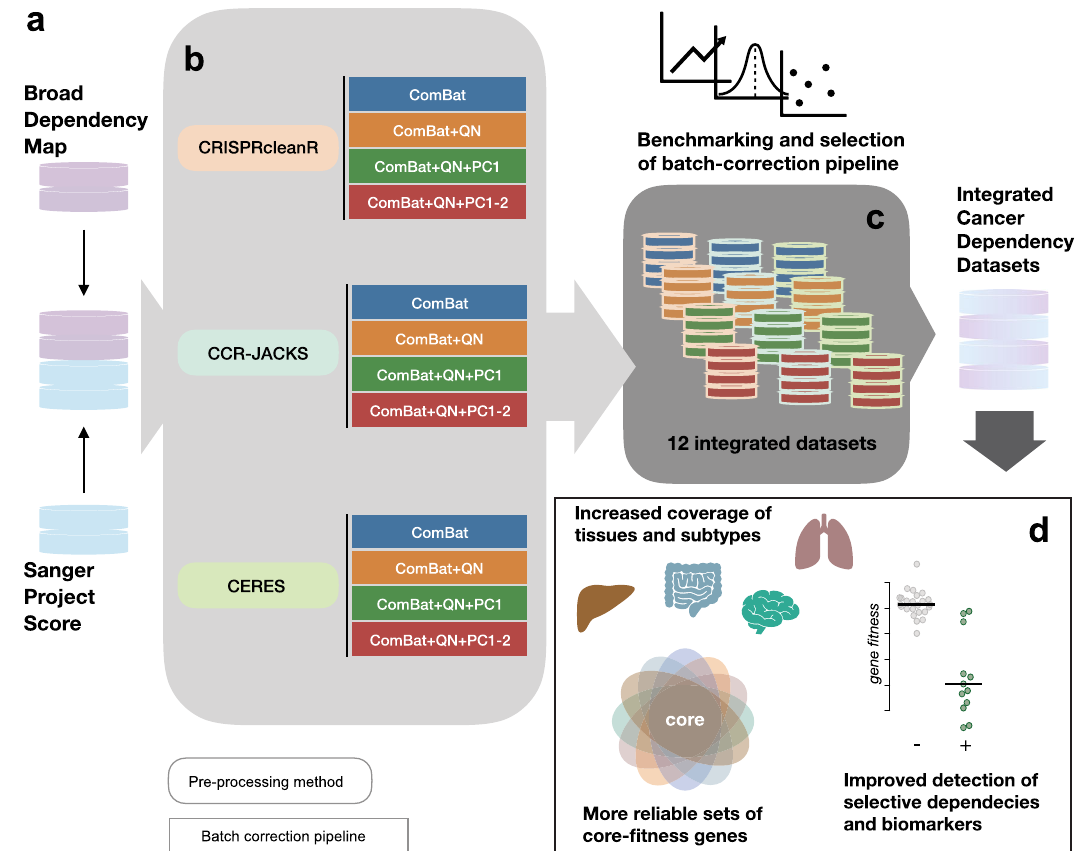
Fig. 1 Schematic of the integration strategy. a Broad and Sanger gene-dependency datasets (raw count data of single-guide RNAs) are downloaded from respective web-portals. b The datasets from each institute are pre-processed with three different methods, accounting for gene-independent responses to CRISPR-cas9 targeting (arising from copy number ampli fi cations) and heterogeneous sgRNA ef fi ciency, providing gene-level corrected depletion fold changes. Then, four different batch-correction pipelines are applied to the gene-level fold changes across the two institute datasets for each of the pre- processing methods. c Twelve different integrated datasets resulting from applying three different pre-processing methods CRISPRcleanR, CRISPRcleanR with JACKS (CCR-JACKS) and CERES (as indicated by the border colors) and four different batch-correction pipelines ComBat only (ComBat), ComBat with quantile normalization (ComBat + QN) and ComBat + QN with either the fi rst principal component (PC) removed (ComBat + QN + PC1) or fi rst two PCs removed (ComBat + QN + PC1-2) (as indicated by the fi ll colors) are benchmarked. d Advantages provided by the fi nal integrated datasets and conservation of analytical outcomes from the individual ones are